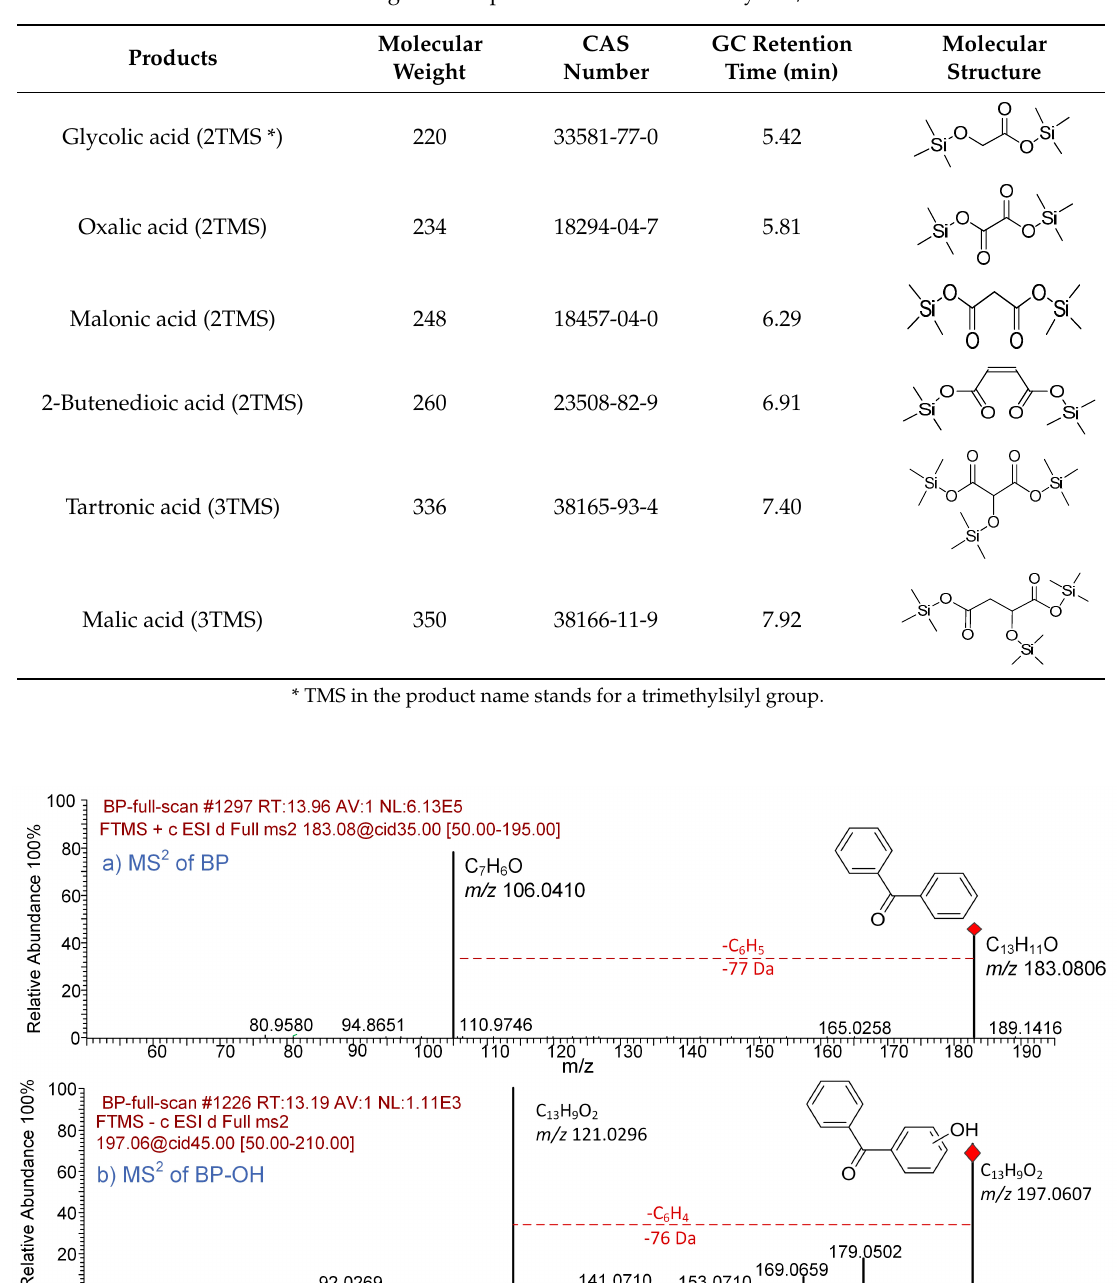
Figure 7. MS 2 spectra of BP and its degradation product obtained by LTQ-Orbitrap. ( a ) BP, ( b ) BP- OH.